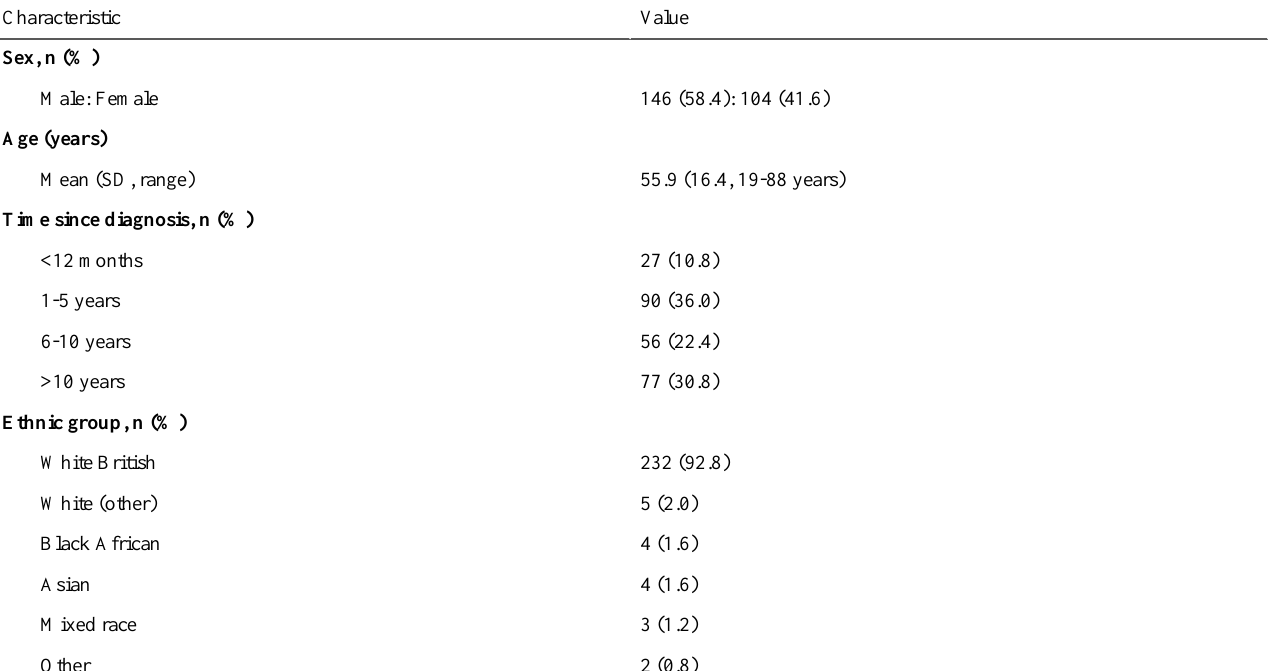
Table 1. Participant